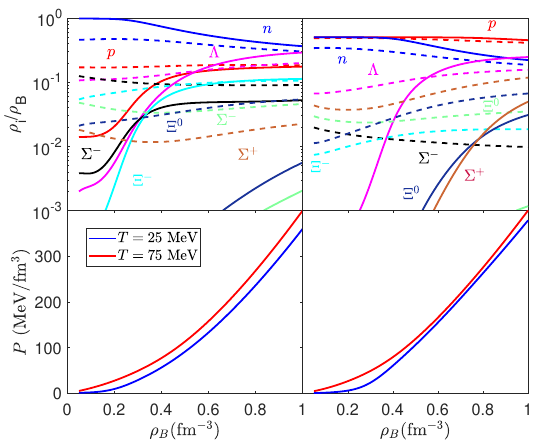
Figure 1. Composition and pressure as a function of baryonic density of the hyperonic core of neutron stars at Y Q = 0 . 01 (left panels) and Y Q = 0 . 5 (right panels). The solid lines in the upper plots are the compositions obtained at T = 25 MeV, while the dashed lines are the compositions at T = 75